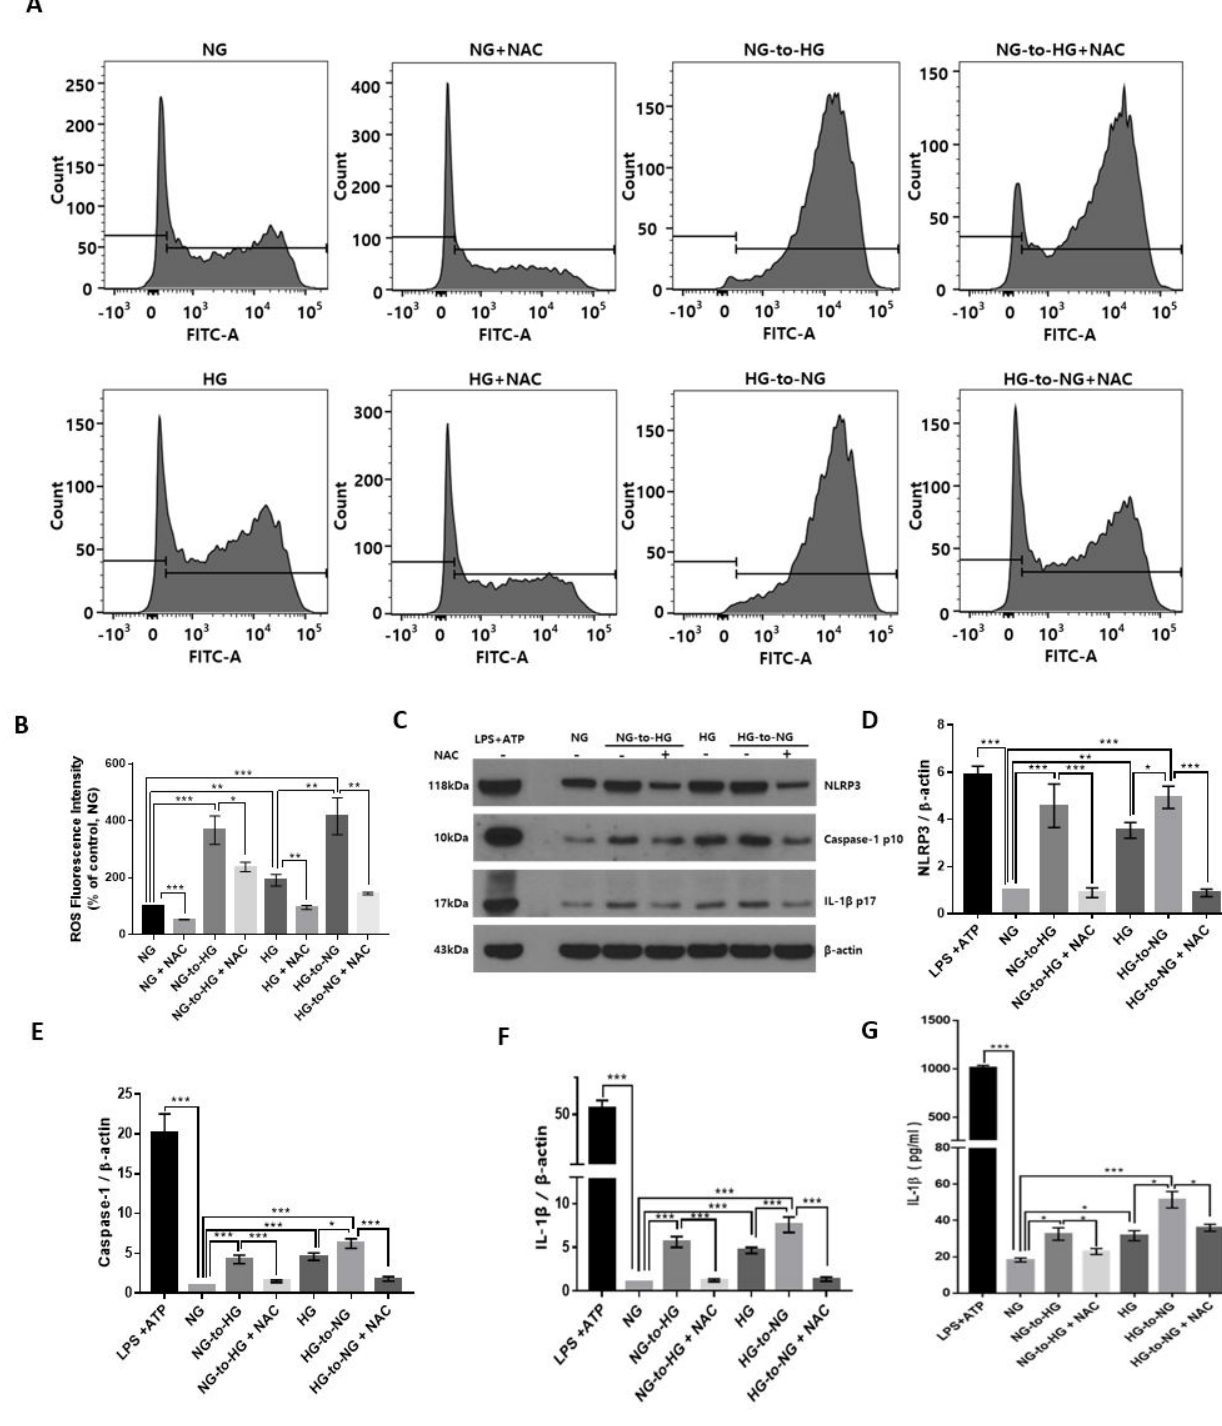
Figure 3. Effect of the acute glucose shift-induced generation of ROS on the activation of the NLRP3 inflammasome in THP-1 cells. Before any glucose shift, cells were pretreated with a pharmacological antioxidant, NAC (10 mM) for 1 h and then exposed to a glucose shift for 24 h. ( A ) The intracellular ROS level was measured by flow cytometry using CM-H2DCFDA. ( B ) Mean fluorescence intensity of the levels of ROS is presented as a percentage of the NG control. ( C ) Cell lysates were subjected to western blotting using antibodies against NLRP3, caspase-1, and IL-1 β . ( D – F ) The protein expression levels of NLRP3, caspase-1, and IL-1 β were quantified using ImageJ. ( G ) The level of IL-1 β in the culture supernatant was determined by ELISA. Data are presented as the mean ± SEM from at least three independent experiments. * p < 0.05, ** p < 0.01, *** p <